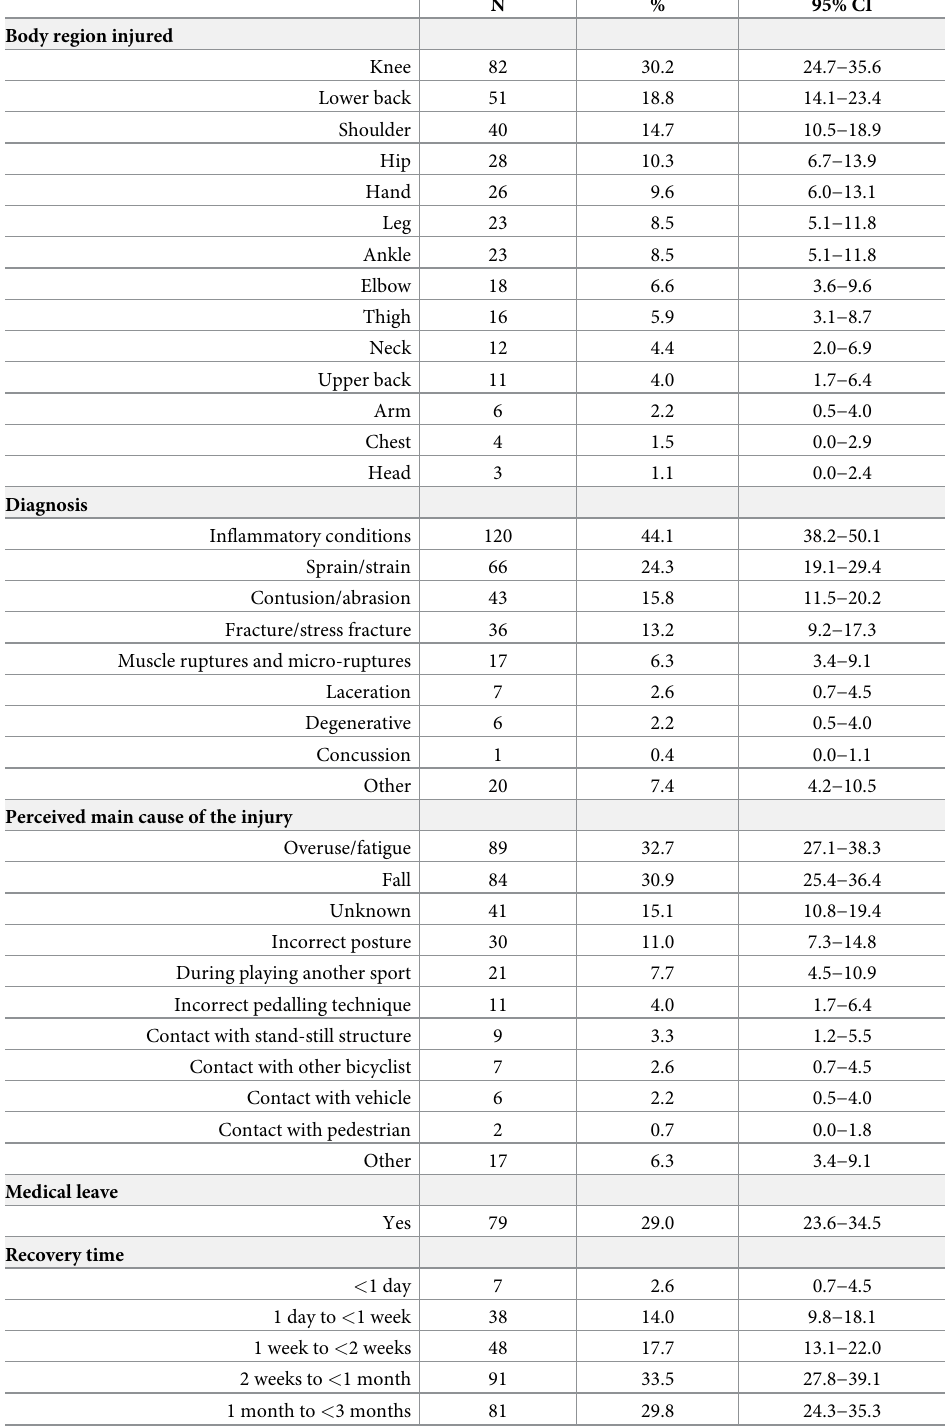
Table 2. Characteristics of injuries reported by participants within the last 12 months. Percentages were obtained from the total number of cyclists injured (n =